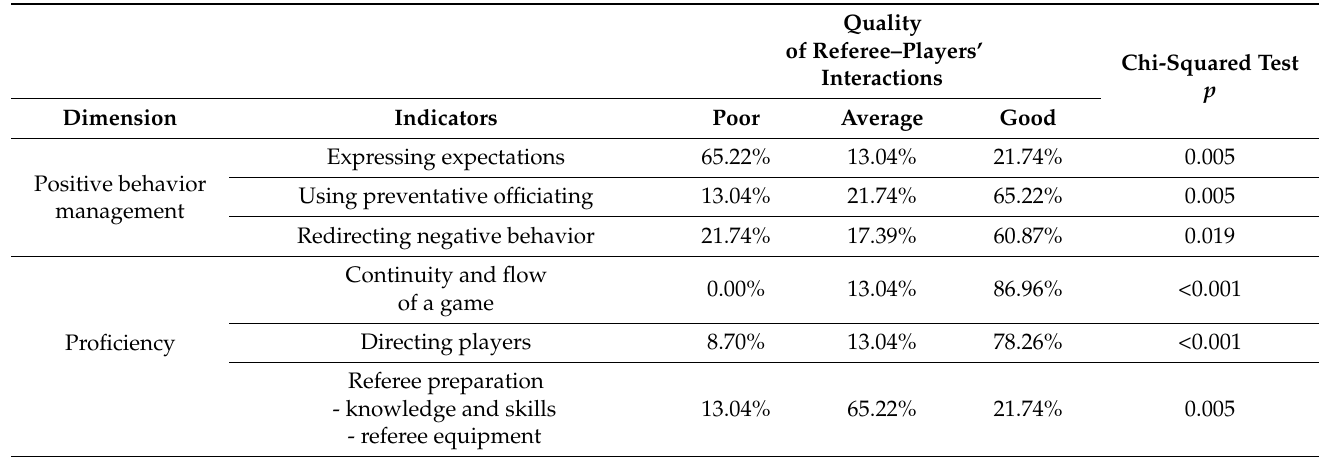
Table 5. Assessment of the quality of referee–player interactions in the dimensions of positive behavior management and proficiency during children’s rugby competitions ( n = 23).